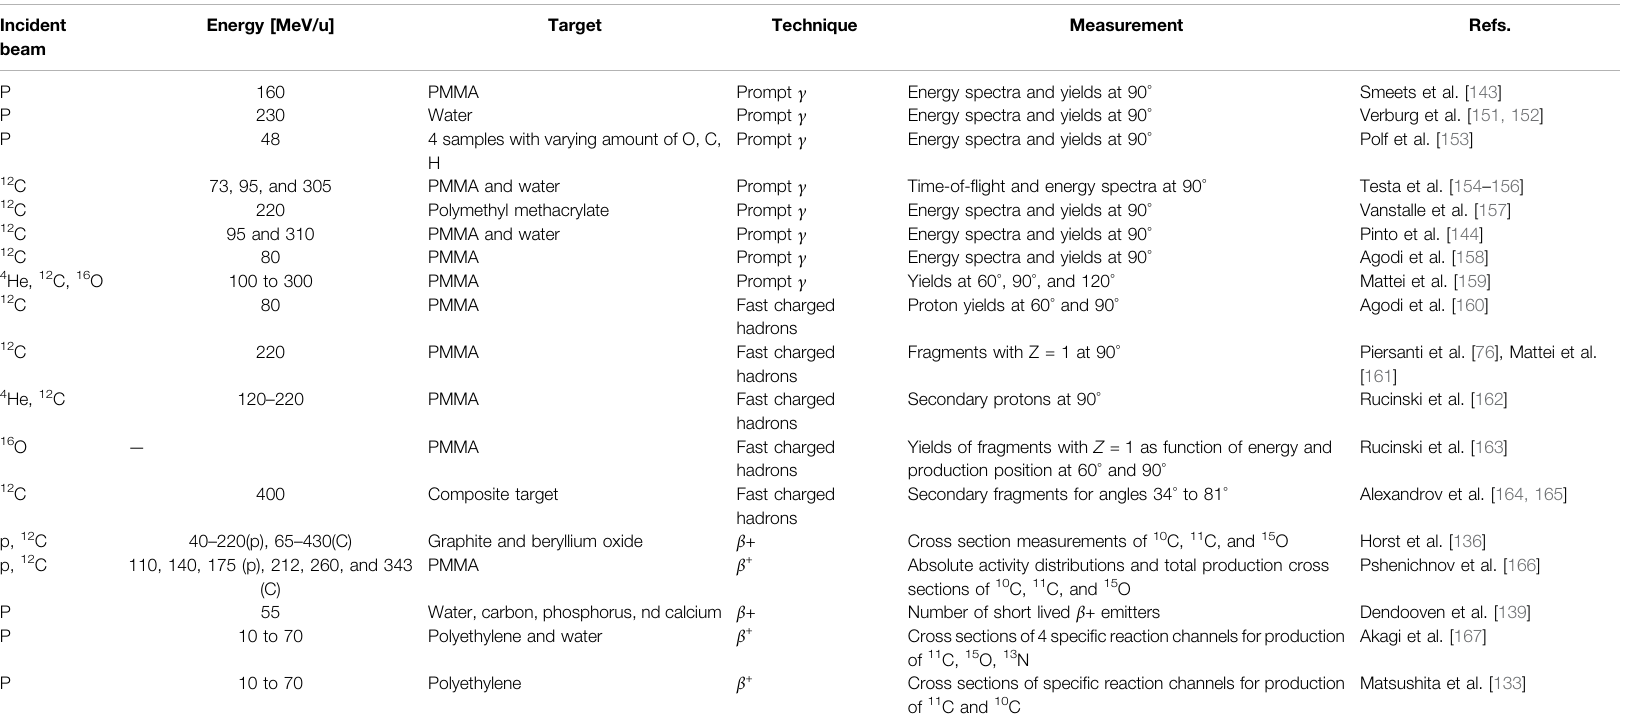
TABLE 3 | Summary of measurements in the context of range monitoring